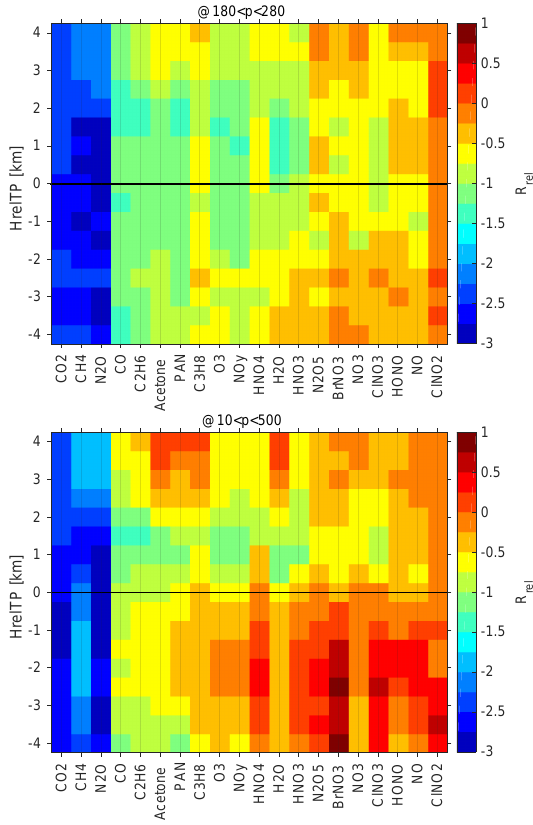
Figure A1. R rel calculated from MOD regular MOD RANDLOC with the range of p set to 180hPa < p < 280hPa (top) and 10hPa < p < 500hPa (bottom). Low values indicate small climatological differences. The difference between the two panels shows the influence of expanding the limits in p when calculating the climatological mean values with HrelTP used as a vertical